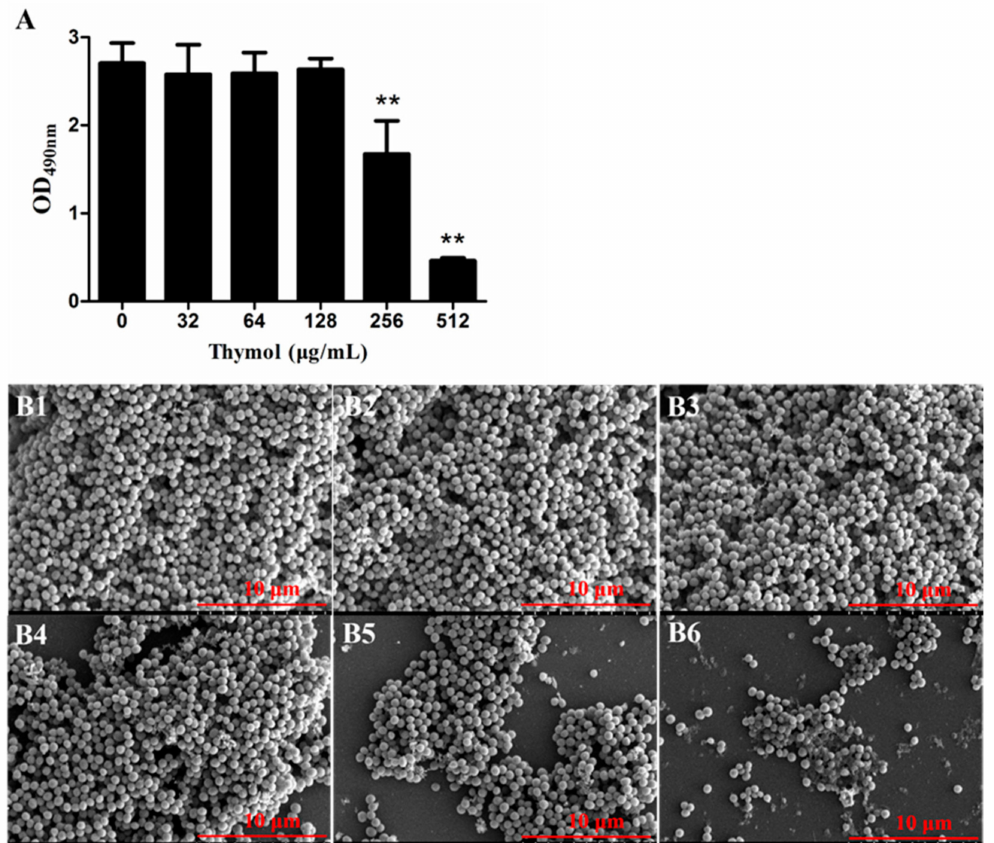
Figure 3. The biofilm removal e ff ect of thymol on pre-existing TCH1516 biofilms. ( A ) Crystal violet staining of treated and untreated biofilms. ( B ) SEM images of treated and untreated biofilms. The biofilms in B1, B2, B3, B4, B5 and B6 were treated with 0, 32, 64, 128, 256 and 512 µ g / mL thymol, respectively ** p < 0.01, compared with the untreated (0 µ g / mL)